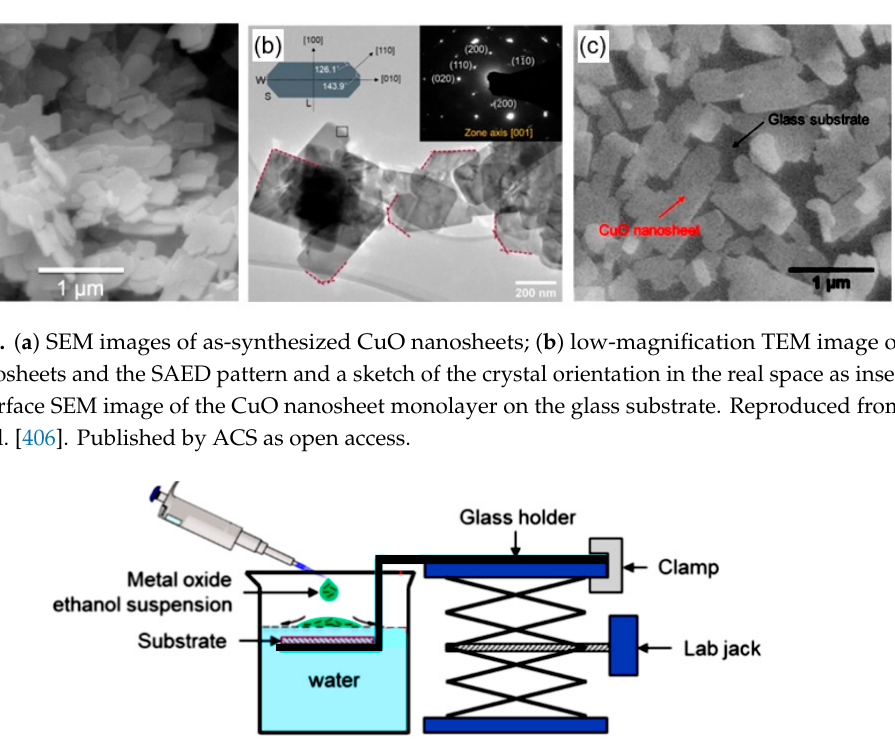
Figure 48. Illustration of the monolayer film formation process using the home-built coater. The red box illustrates that the CuO nanosheets float on the water surface due to the formation of a negative meniscus at the edges and self-assembly due to the attraction force of the same type of meniscus. Reproduced from Miao et al. [406]. Published by ACS as open access.